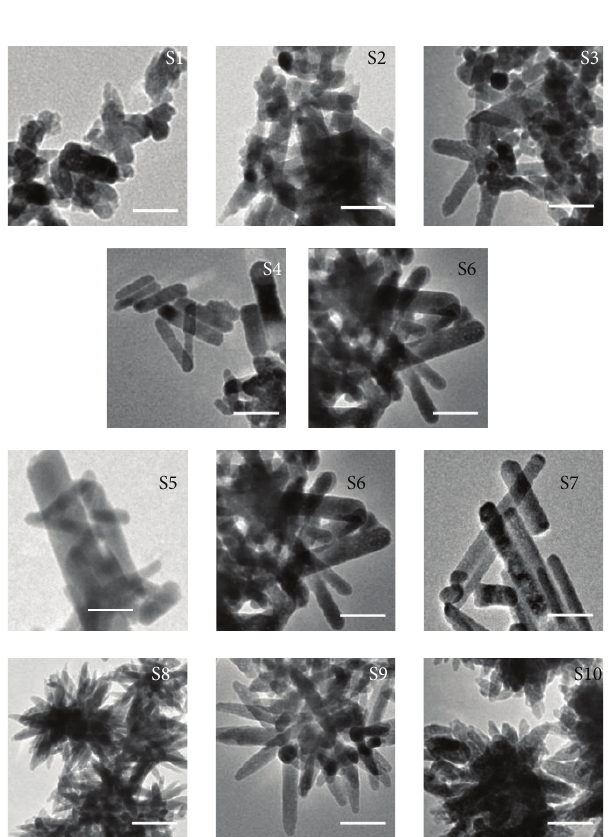
Figure 8: TEM images showing the morphology and size of synthetic lead apatites. The effect of increasing the chloride is